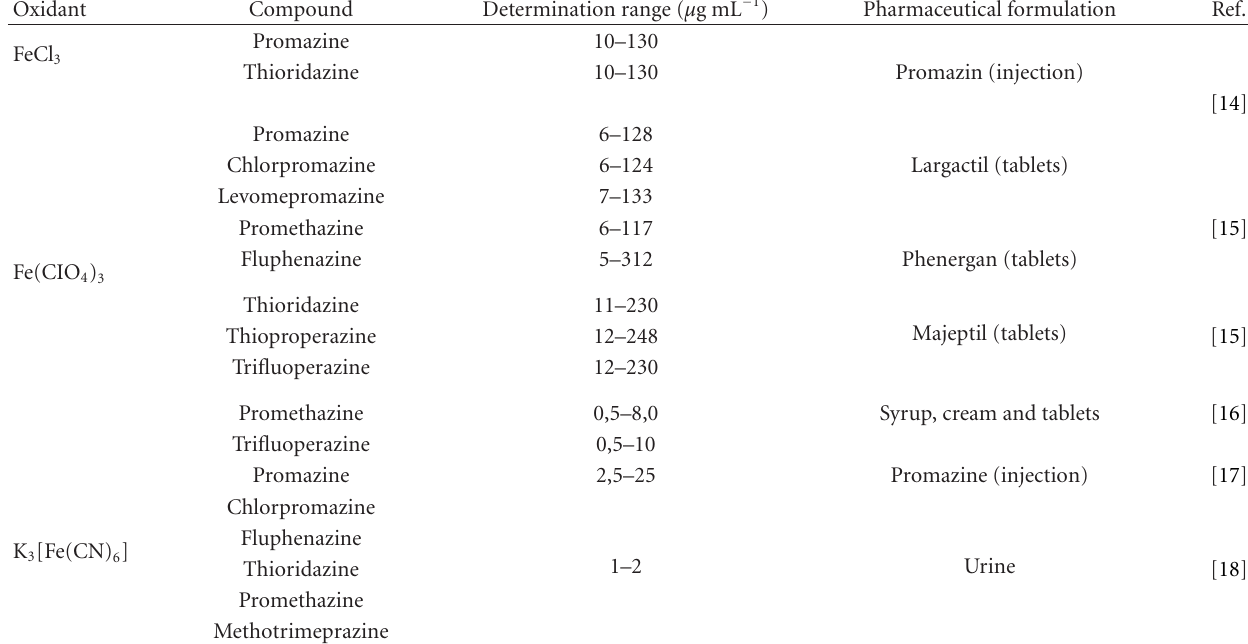
] using flow injection methods. 6